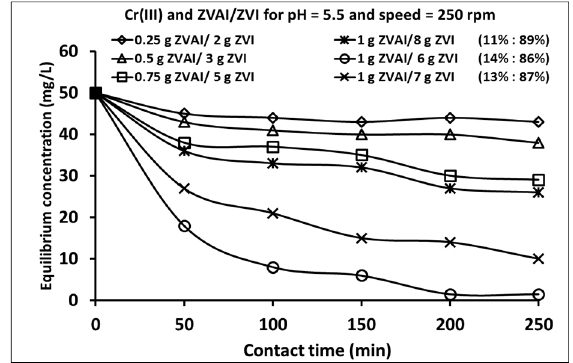
Fig. 6. Variation of equilibrium Cr(III) concentration as a function of contact time using different proportions of ZVAI / ZVI.